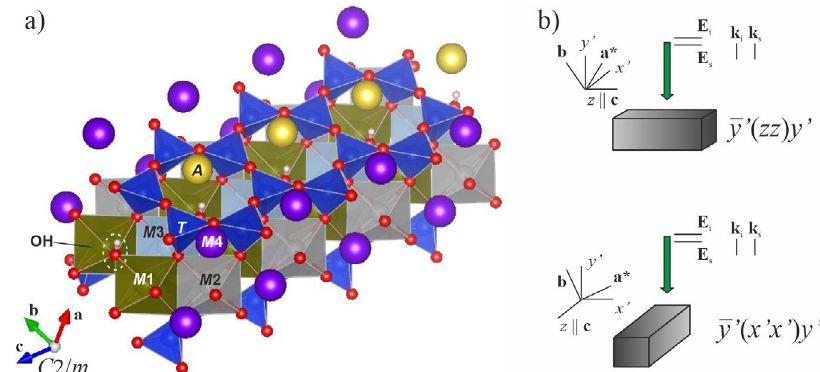
Fig. 1 Amphibole structure and scattering geometries. a Fragment of the structure of a W (OH)-amphibole with C 2/ m symmetry; T O 4 tetrahedra are given in blue, whereas M (1)O 6 , M (2)O 6 , and M (3)O 6 octahedra in olive-greenish, gray, and light-bluish, respectively. Large yellow and violet spheres represent the A - and M (4)-site cations; the small red spheres are the oxygen atoms. The dashed ellipse marks a W (OH) − group. The fi gure was prepared using the VESTA software package 51 . b Sketch of the experimental geometry used in the Raman scattering experiments. a – c are the fundamental translation vectors of C 2/ m in the direct space, a* in the reciprocal space, i.e. a* ⊥ b ⊥ c